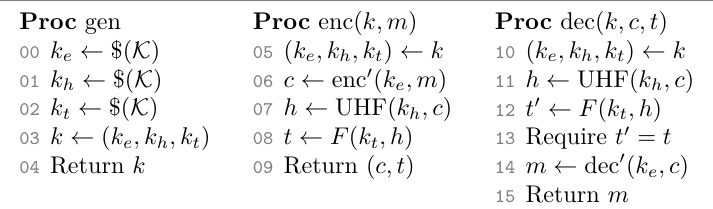
Figure 10: We let K = { 0 , 1 } 256 , and use enc 0 , dec 0 and UHF and F as placeholders for CPA- secure encryption/decryption algorithms, a universal hash function, and a pseudorandom function, respectively, all with key space K . If the condition in line 13 is not fulfilled, the dec algorithm fails.